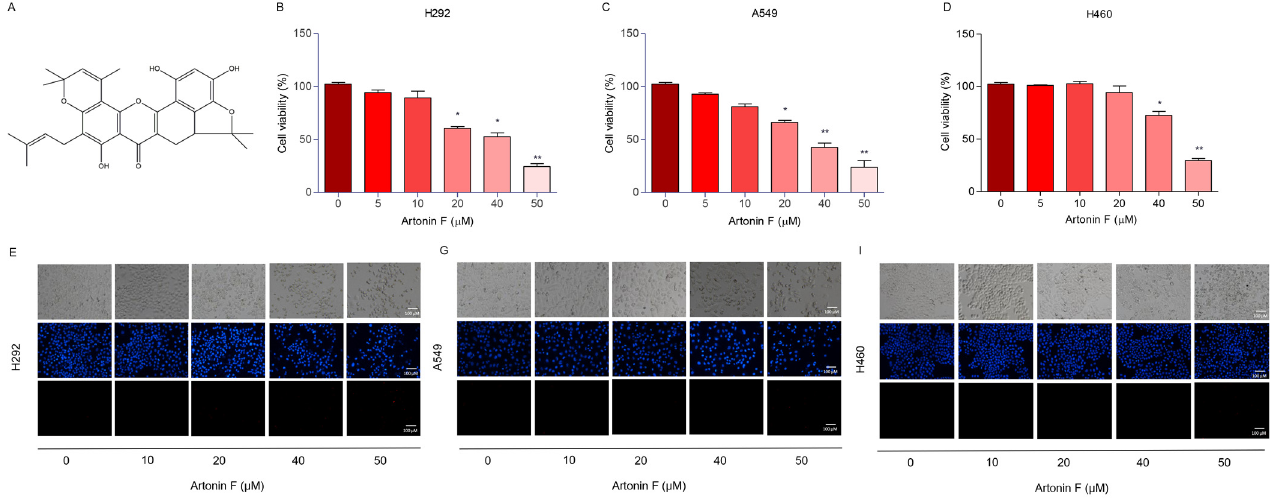
Figure 1. Cytotoxicity of artonin F on human lung cancer cells. ( A ) Chemical structure of artonin F. ( B – D ) Effect of artonin F on cell viability of lung cancer cells (H292, A549, and H460 cells) was as- sessed by the 3-[4,5-dimethylthiazol-2-yl]-2,5 diphenyl tetrazo-liumbromide (MTT) assay. ( E – J ) Morphology of apoptotic nuclei stained with Hoechst 33342 dye and propidium iodide in cells treated with artonin F, determined by visualized using fluorescence microscopy and percentages of